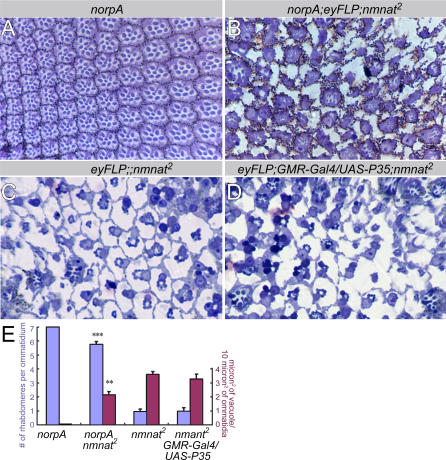
Loss of NMNAT-Induced Degeneration Can Be Attenuated by Blocking Phototransduction and Is Independent of Apoptosis(A) and (B) Ommatidial morphology of 1-d-old norpA mutant (A) or norp; nmnat double mutant (B) retina. norpA mutant retina appears normal at this age. norpA; nmnat double mutant retina has greatly improved rhabdomere structure when compared to nmnat single mutant (C).(C) and (D) Ommatidial morphology of nmnat mutant retina (C) or mutant retina overexpressing P35 (D). There are no detectable differences between (C) and (D), suggesting that P35 overexpression does not rescue the degeneration induced by loss of nmnat.(E) Quantification of the number of rhabdomeres and vacuole size for each genotype. Blue columns are the number of rhabdomeres per ommatidium, and the red columns are the vacuole size per 10 μm2 of ommatidia. Six animals per genotype and 400 μm2 of ommatidia per animal were quantified. Double asterisks (**) indicate p < 0.005; and triple asterisks (***) indicate p < 0.0005 (Student t-test).